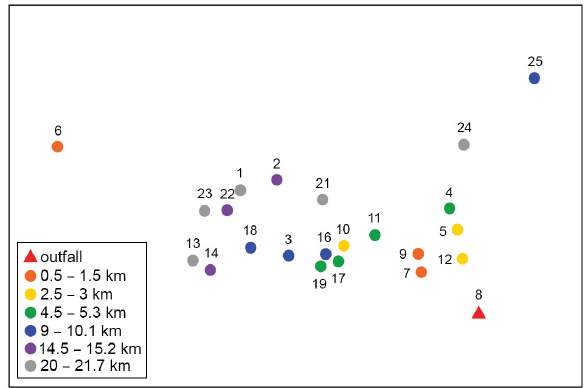
Fig. 5. Non-metric multidimensional scaling analysis of bac- terial and archaeal community composition at each